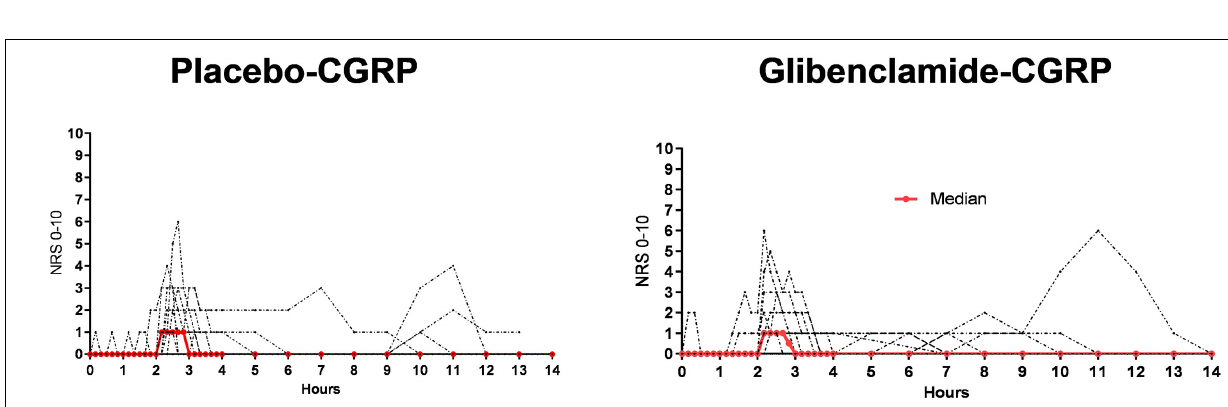
Frontiers in Physiology |